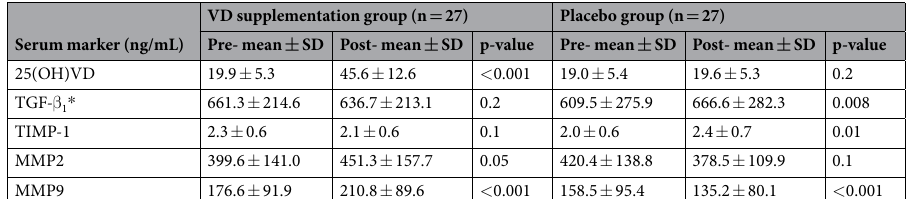
Table 2. Mean serum levels of each marker at baseline (Pre) and after 6 weeks of follow-up (Post) in the VD and placebo groups. * pg/mL.